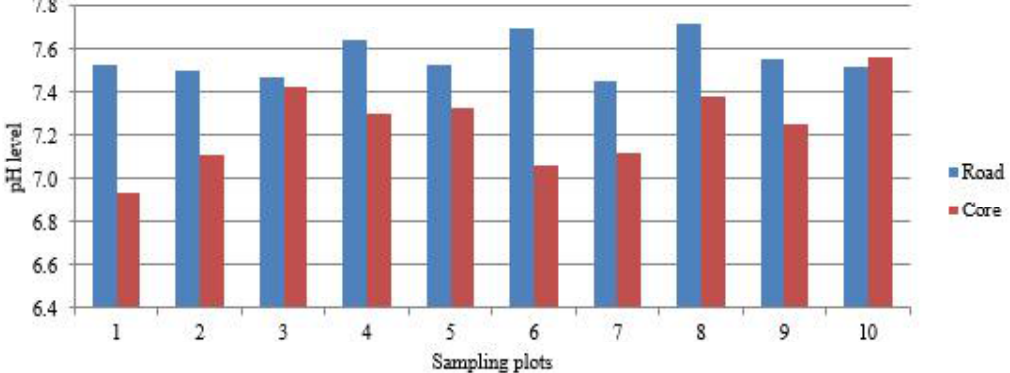
Fig. 8: Variation of soil pH level between road verge and core area